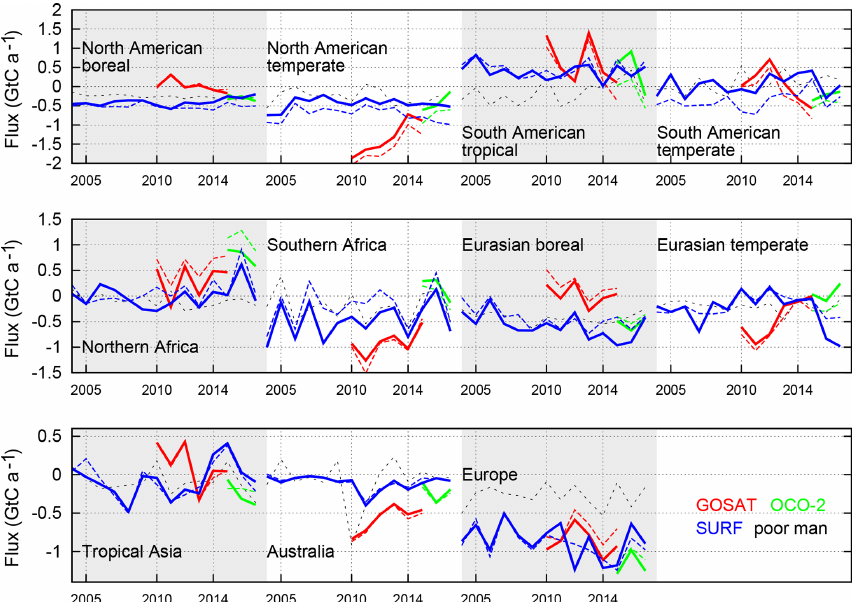
Figure 3. Time series of inferred natural CO 2 annual flux (without the prescribed fossil fuel emissions) between 2004 and 2017, averaged over TransCom 3 land regions. Inversions with LMDz5A (LMDz6A) are shown using continuous (dashed) coloured lines. In the sign convention, positive fluxes correspond to a net carbon source into the atmosphere. The last year of the GOSAT inversions (2016) is not represented because of likely edge effects. Note that the prior fluxes are zero over land at this temporal scale (see Sect.